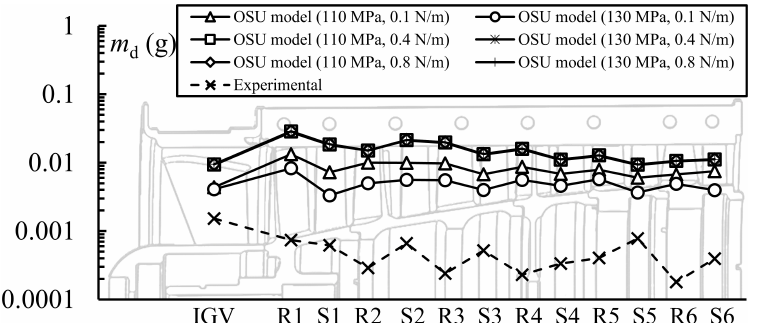
Figure 14. Comparison between the OSU model results and experimental values of the deposited mass on the compressor